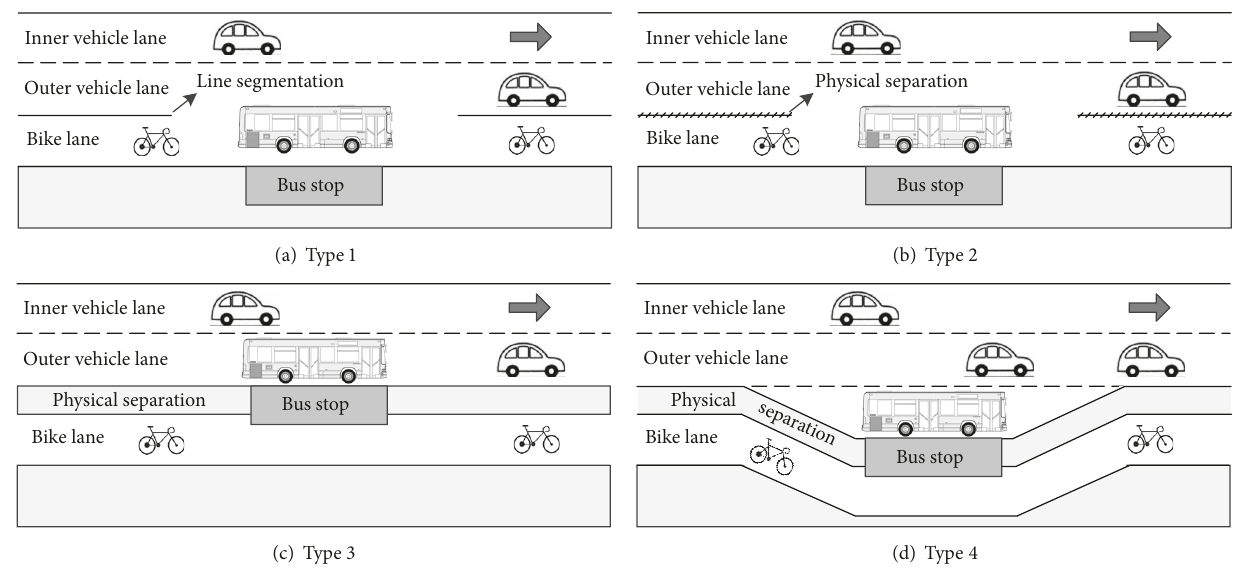
Figure 1: Illustration of four types of bus stops